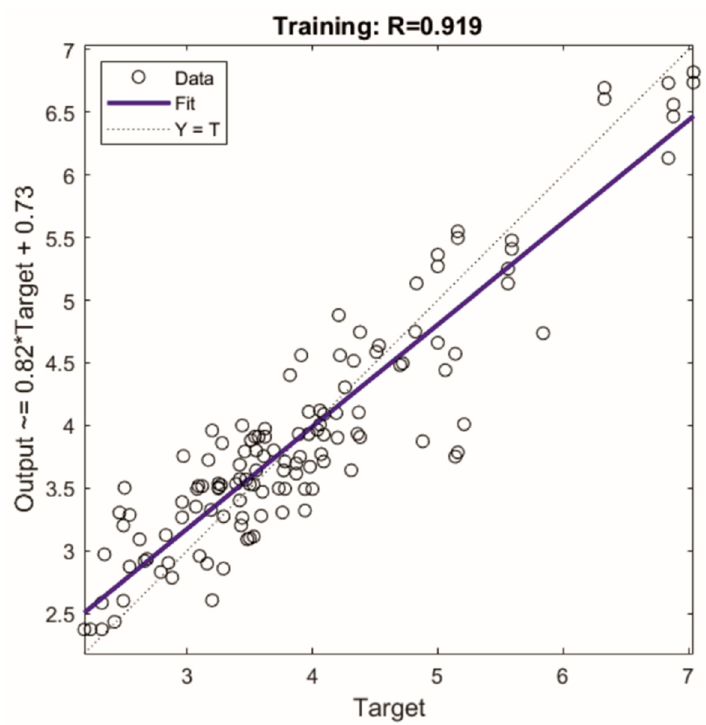
Figure 9. Training result for Marshall Stability ANN model.